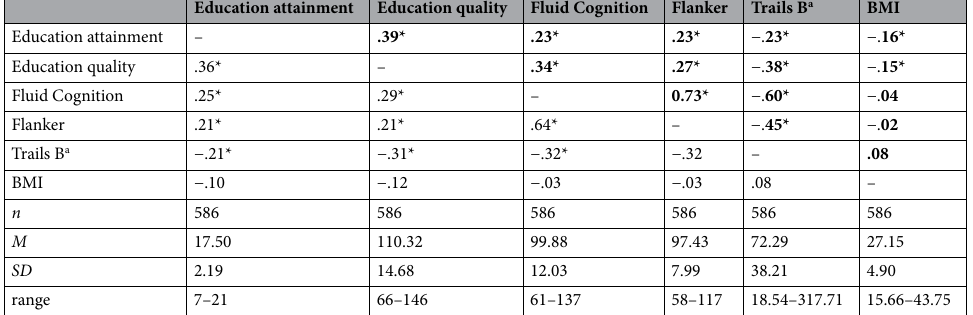
Table 2. Correlations among primary study variables and descriptive statistics for each variable in the HCP-A data set. Bolded values above the diagonal are bivariate correlations and those below the diagonal are partial correlations adjusted for age, sex and ethnoracial category. ƚ p < .06, * p < .05, a = one outlier windsorized for